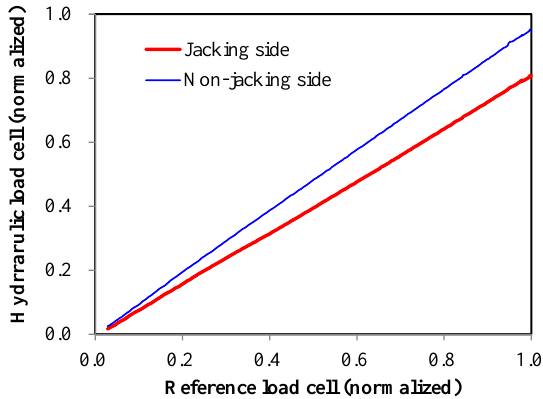
Figure 7. Relationship of the measurements between reference and hydraulic load cells.